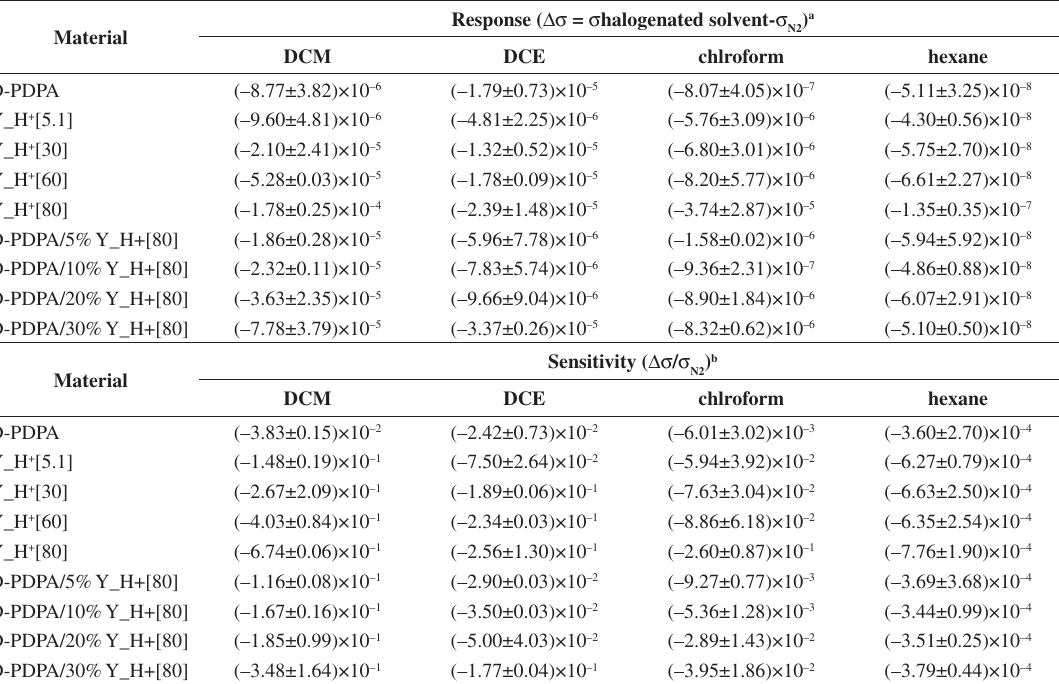
Table 3. Electrical conductivity sensitivity of D-PDPA, Y_H+, D-PDPA/Y_H+[80] when exposed to halogenated and non-halogenated solvents at 27±1°C and 1